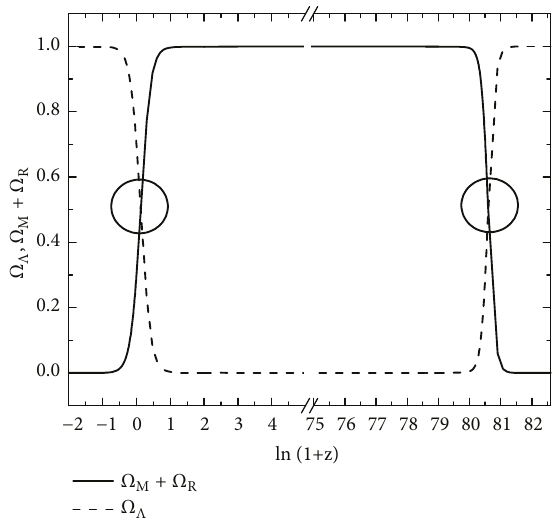
Figure 2: Solution of the coincidence problem in running vacuum cosmologies. The right graphic is our model; the left is Λ CDM. Solid and dashed lines represent the evolution of the vacuum ( Ω Λ ) and total matter-radiation ( Ω 𝑀 + Ω 𝑅 ) density parameters for n=2, ] = 10 −3 , and 𝐻 /𝐻 = 10 60 . The late time coincidence between the 𝐼 0 density parameter of the vacuum and material medium (left circle) has already occurred at very early times (right circle). Note also that the values 5 and 75 in the horizontal axis were glued in order to show the complete evolution (the suppressed part presents exactly the same behavior).Different values of 𝑛 change slightly the value of the redshift for which Ω Λ = Ω 𝑀 +Ω 𝑅 at the very early Universe (see also discussion in the